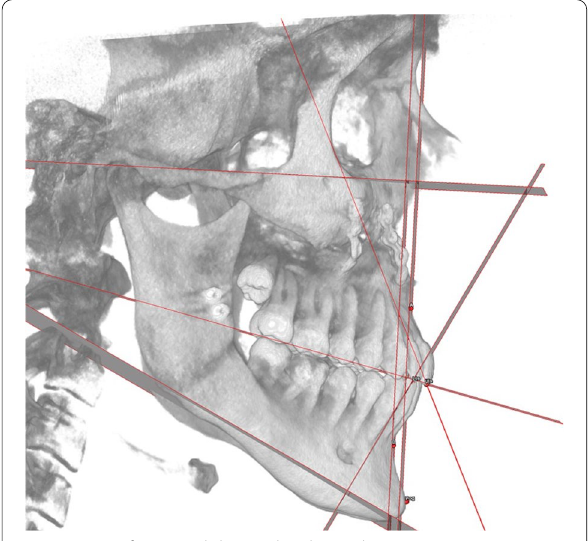
Fig. 6 View of a sagittal dento-alveolar analysis in a PostOp